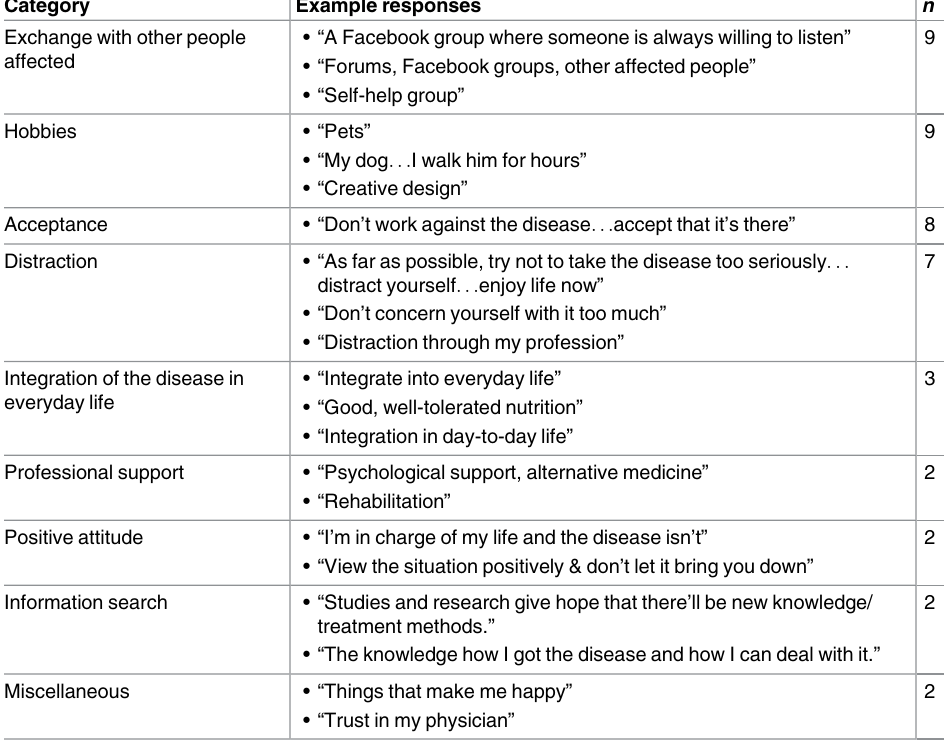
Table 4. Patients’ free-textresponses to questions about their resources for coping with the disease (translated into English by the